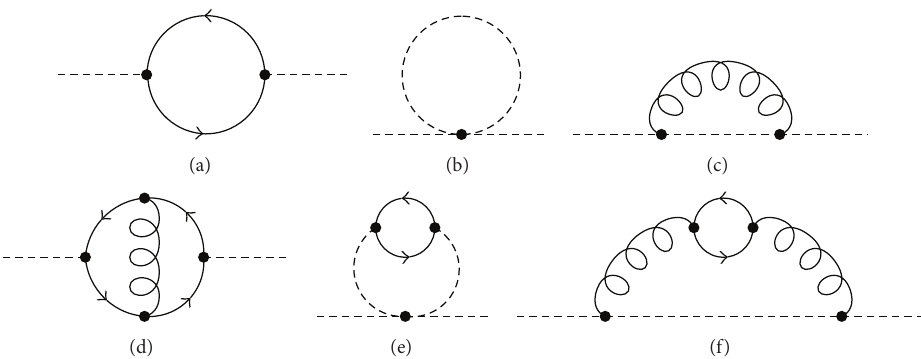
Figure 1: One- and two-loop Feynman diagrams contributing to the 𝜀 -scalar propagator. Dashed lines denote 𝜀 -scalars, curly lines denote the gauge bosons, and solid lines denote massive fermions with mass 𝑀 𝑓